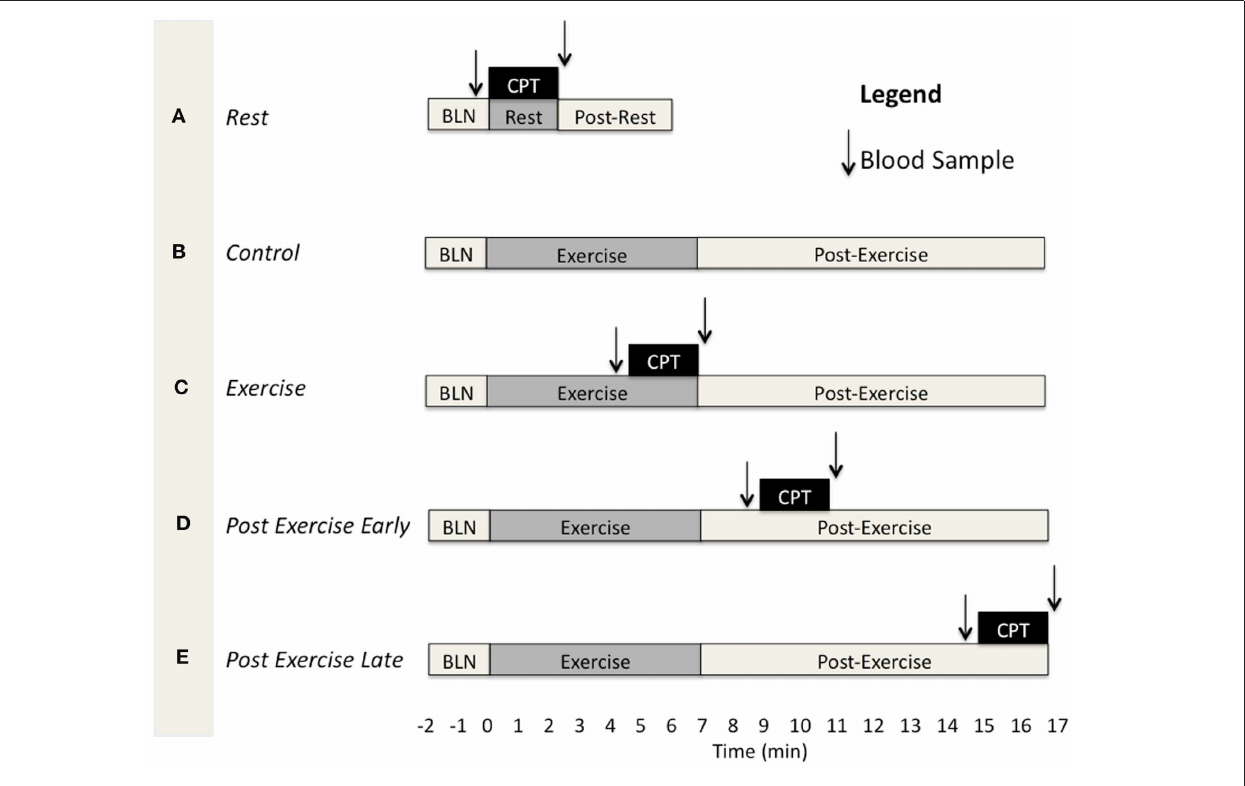
FIGURE 1 | Schematic depicting the different experimental trials and the timing of blood samples and the CPT for each. BLN, resting baseline. CPT, 2min Cold pressor test. (A) CPT during rest. (B)